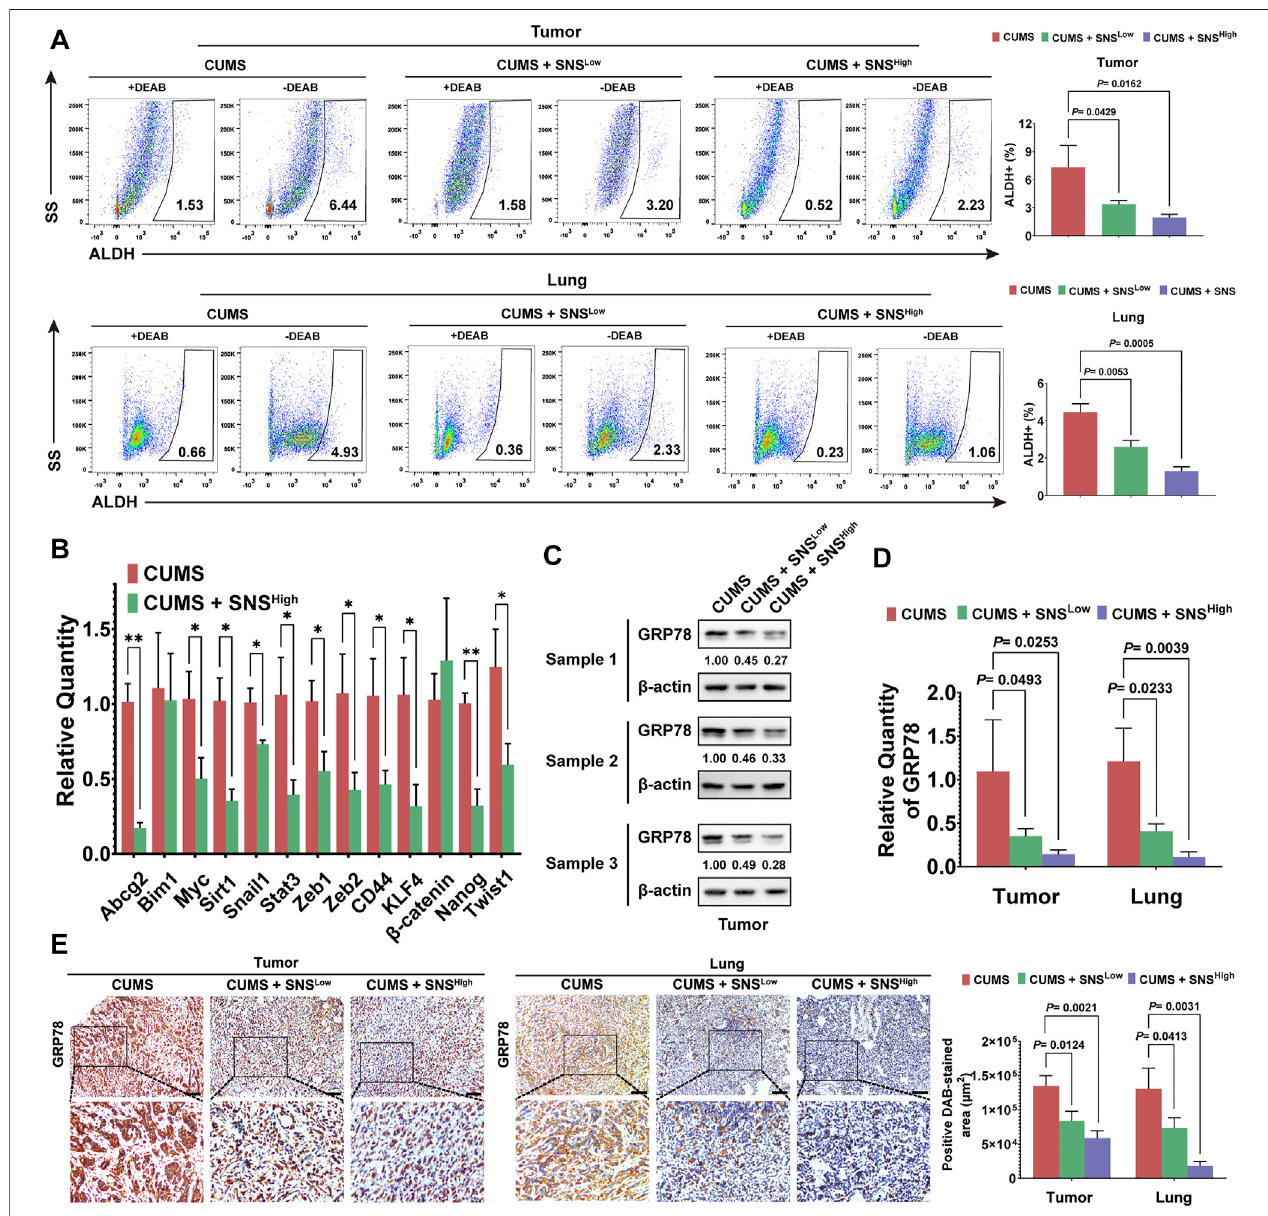
FIGURE 3 | SNS inhibits CUMS-induced GRP78 expression and stemness of breast cancer cells in 4T1 tumor-bearing mice. (A) ALDH activity in the primary tumors and lung metastases were quanti fi ed after SNS treatment. (B) The relative quantity ofstem-related genes in the primary tumor wasdetected by qPCR after SNS treatment. (C) The expression of GRP78 in the primary tumors was detected by western blots after SNS treatment. (D) Relative mRNA expression of GRP78 in the primary andlung metastaticlesions wasmeasured. (E) ExpressionofGRP78 in theprimary and lung metastatic lesions wasdetectedbyimmunohistochemistry(n (cid:2) 8, the scale bars indicate 100 μ m). Data are represented as the mean value ± SD. One representative experiment of three independent experiments is displayed. Unpaired two-sided Student ’ s t-tests were applied, *p < 0.05, **p < 0.01.